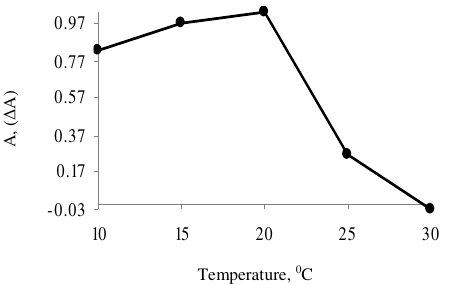
Figure 7. Influence of temperature on the sensitivity. Conditions: 100 ng/mL V(V); H